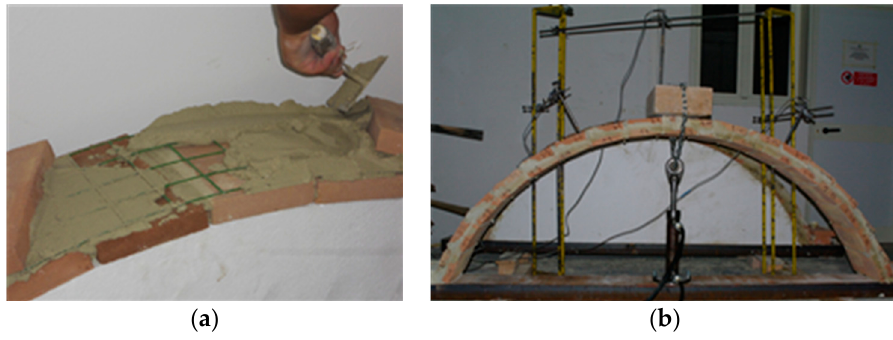
Figure 3. ( a ) Reinforcement application; ( b ) test arrangement.